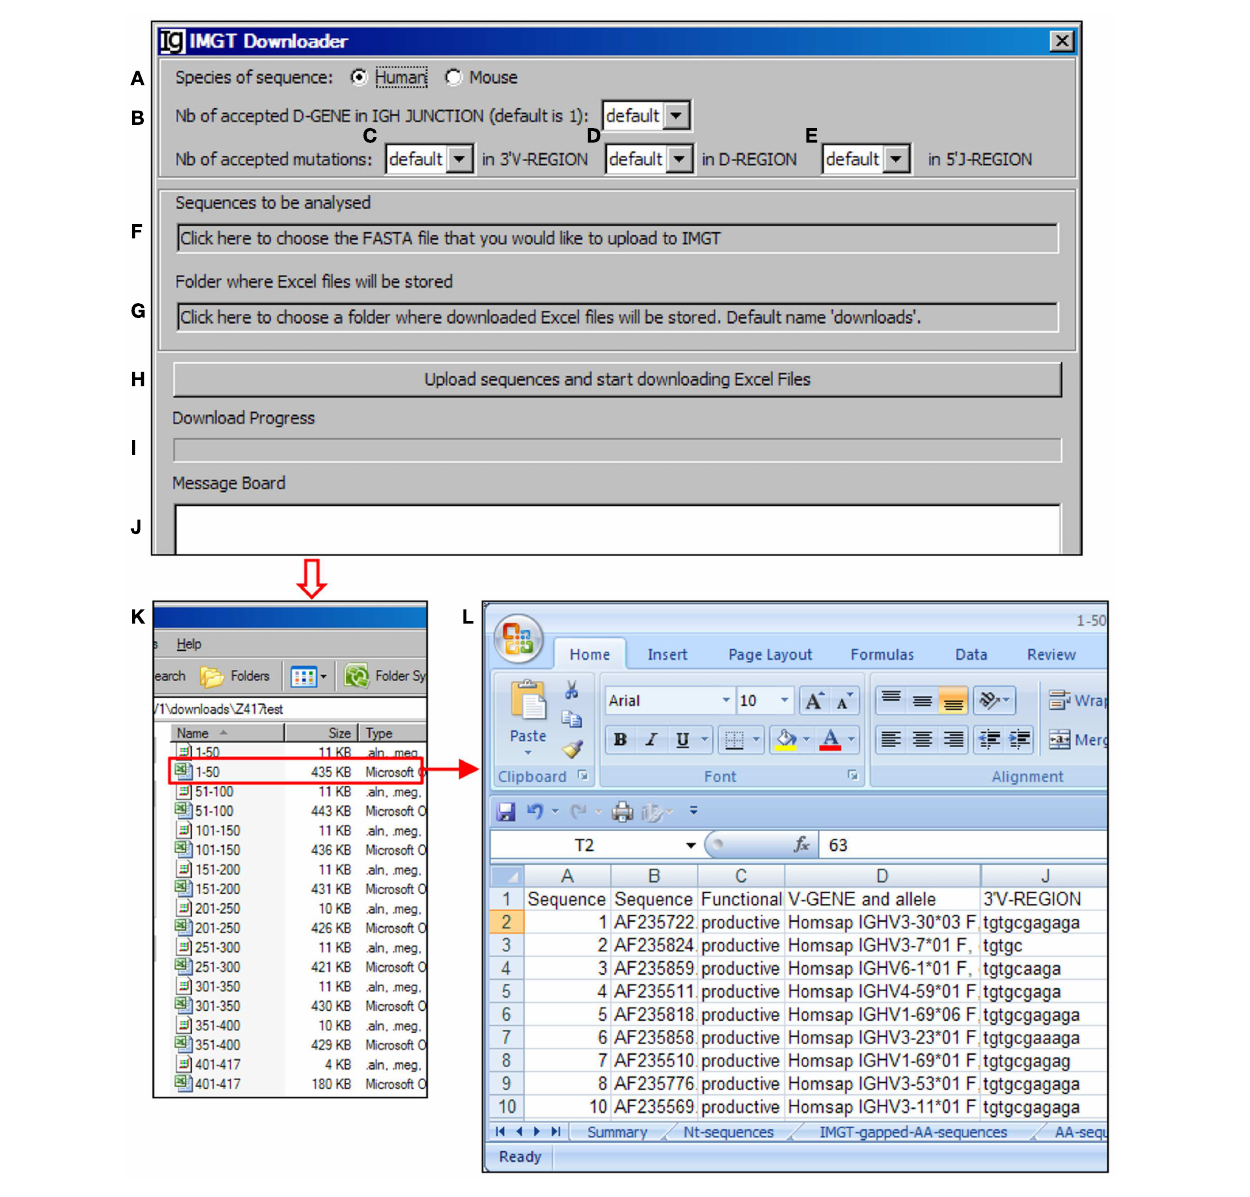
FIGURE 3 |The IMGT downloader . Diagram shows the interface of the IMGT Downloader .The IMGT Downloader allows users to use the IMGT/V-QUEST program to analyze large numbers of IgH gene sequences by uploading IgH sequences and downloadingV-QUEST analysis results to a local computer.The user can specify human or mouse sequences (A) , numbers of D H genes (default = 1) (B) , number of accepted mutations in the 3 (cid:48) V H region (C) , D H region (D) , and 5 (cid:48) J H region (E) . After these settings, the